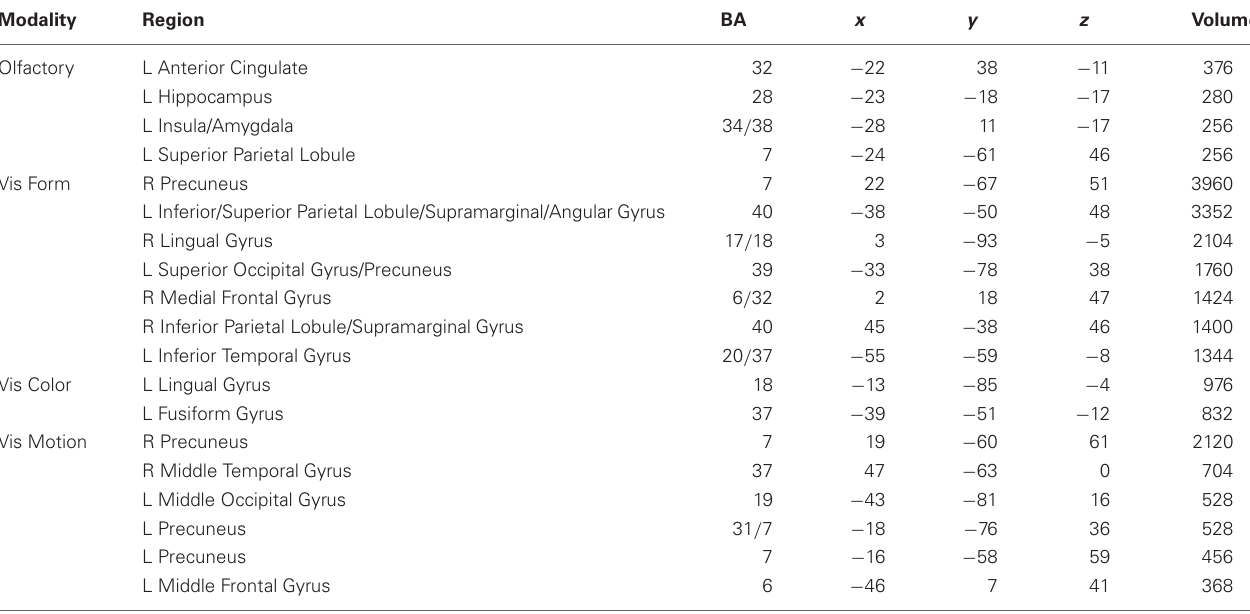
Table 4 | Weighted centers of significant clusters in the olfactory, visual form, visual color, and visual motion imagery ALE analyses.